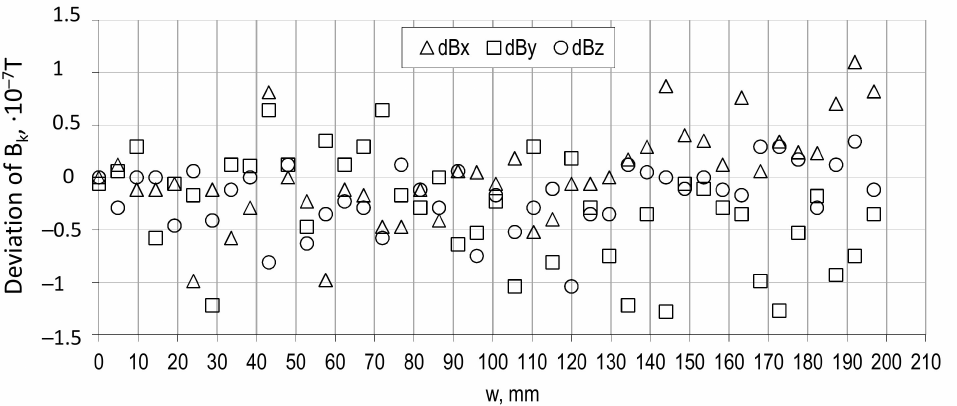
Figure 6. The discrepancy denoted as dB x , dB y , dB z between mean values of B x , B y , B z of sig- nals at perfect stop and during device operation as during measurement without wheel fixed for h 0 = 450 mm and variable w (width of tire’s tread). The k index in B k means x, y, or z index as